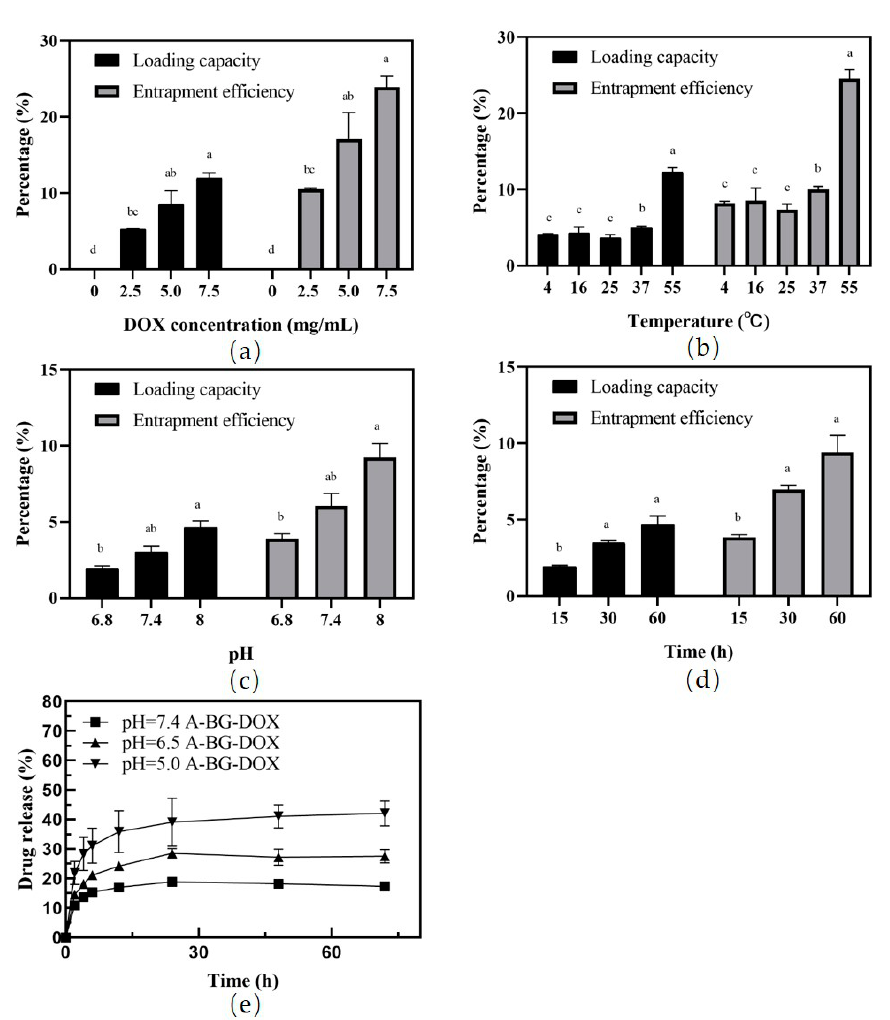
Figure 4. DOX packaging and release assays. Effects of drug concentration ( a ), incubation temperature ( b ), incubation time ( c ), and Tris-HCl buffer pH ( d ) on the drug loading capacity and encapsulation rate. DOX release profiles from A-BG-DOX in PBS at different pH values ( e ). a, b, c, d: significant differences ( p < 0.05) among different groups.